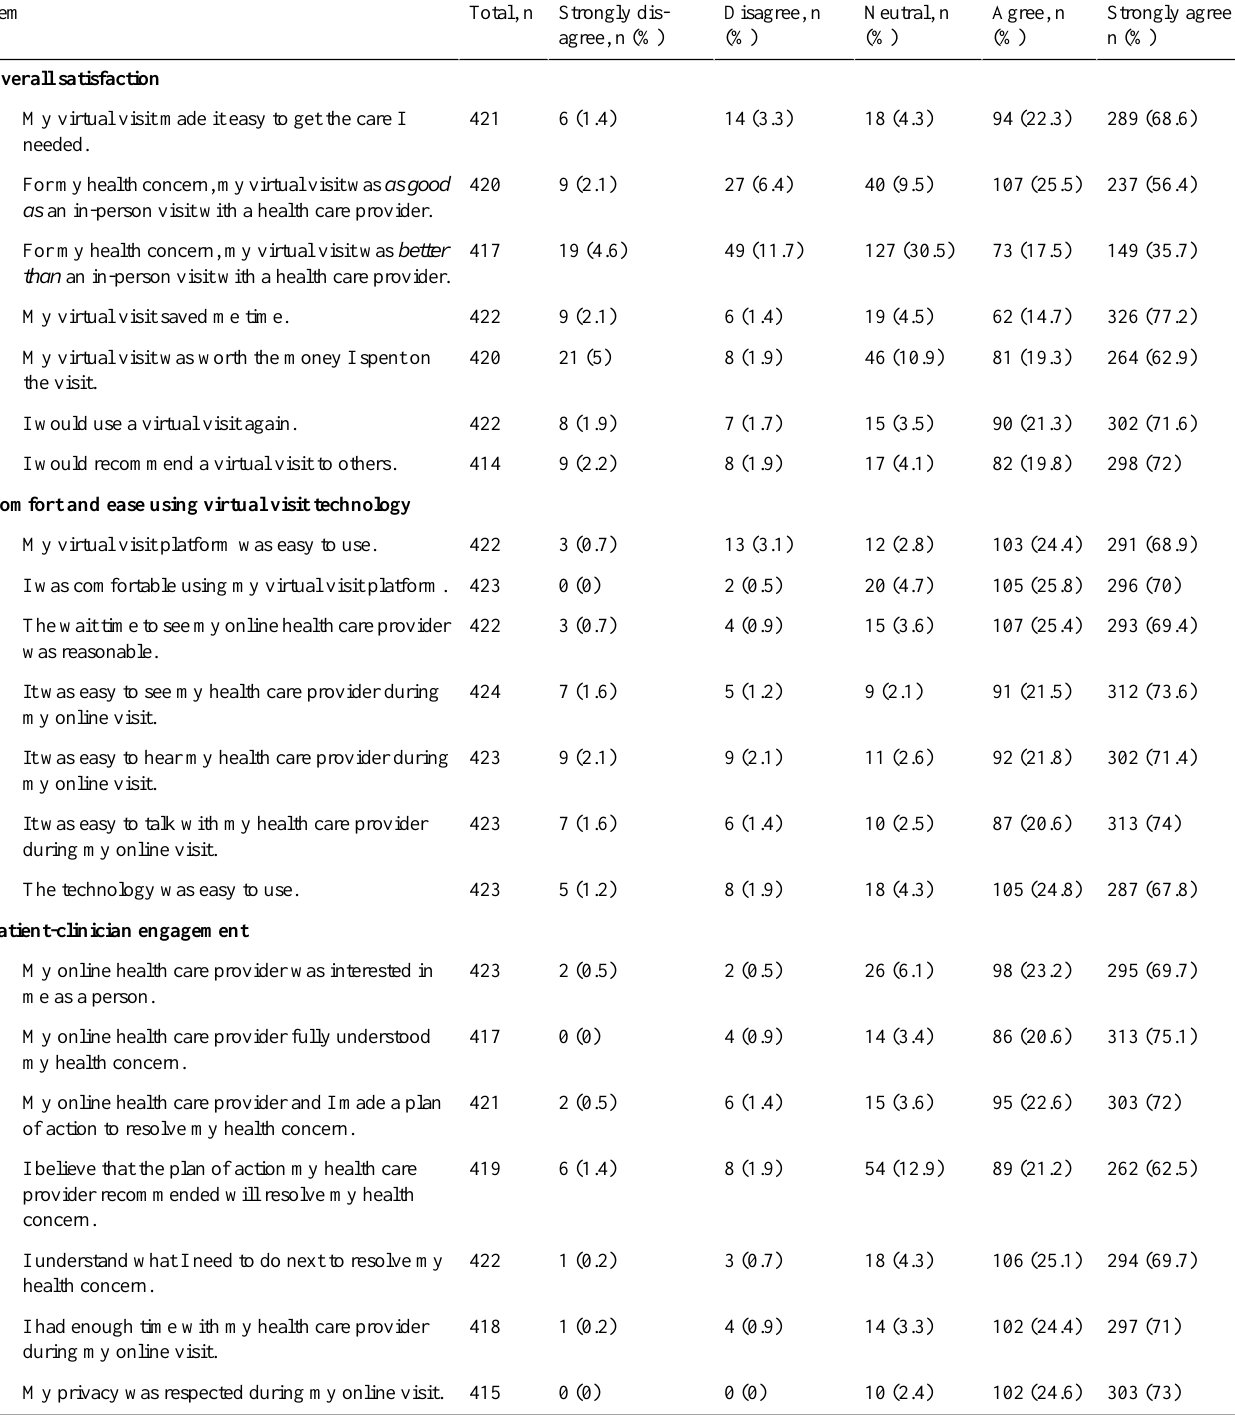
Table 2. Patient responses to Likert scale survey items (N=426).